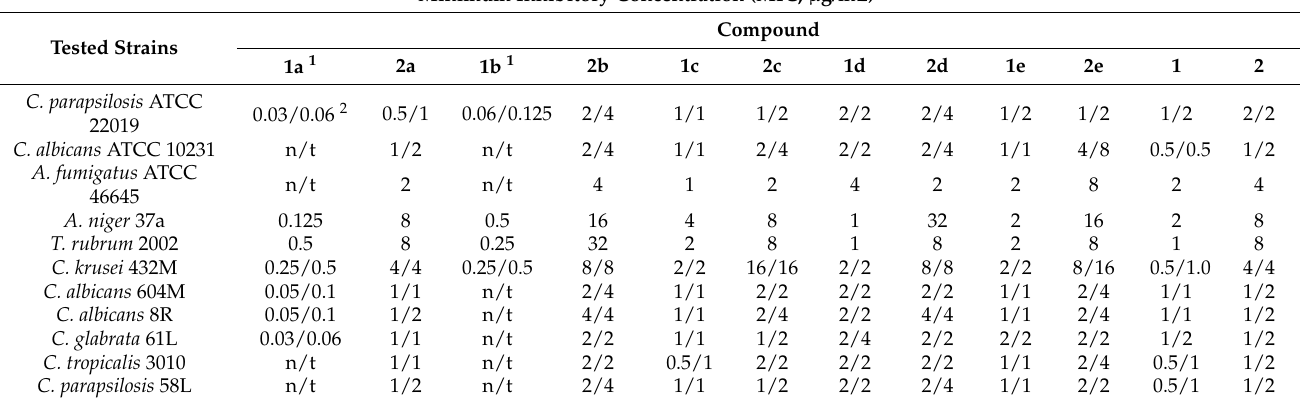
Table 1. The antifungal activity of the semisynthetic polyene antibiotic derivatives 1a – 1e , 2a – 2e in comparison with AmB ( 1 ) and Nys ( 2